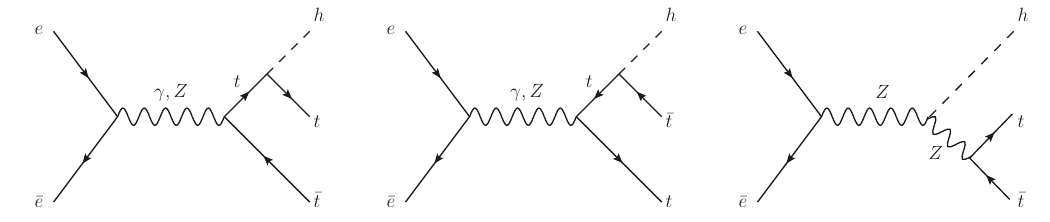
Figure 1 . The Feynman diagrams of the e (cid:22) e